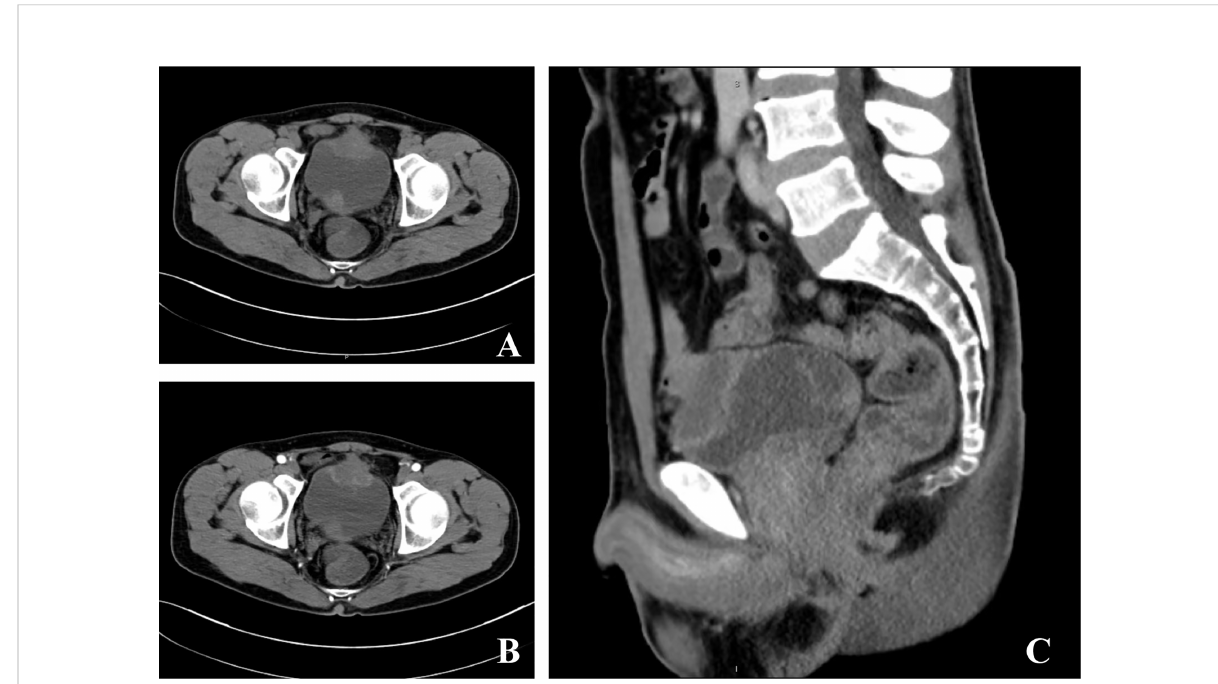
FIGURE 1 Computed tomography of the current urachal signet ring cell carcinoma case. (A, B) A tumor with the size of 4.0 cm × 2.7 cm × 4.0 cm and progressive annular enhancement was observed in the anterior wall of the bladder. The mass in the trigone of the bladder was con fi rmed to be a blood clot via cystoscopy. (C) The tumor extended superiorly up to just below the